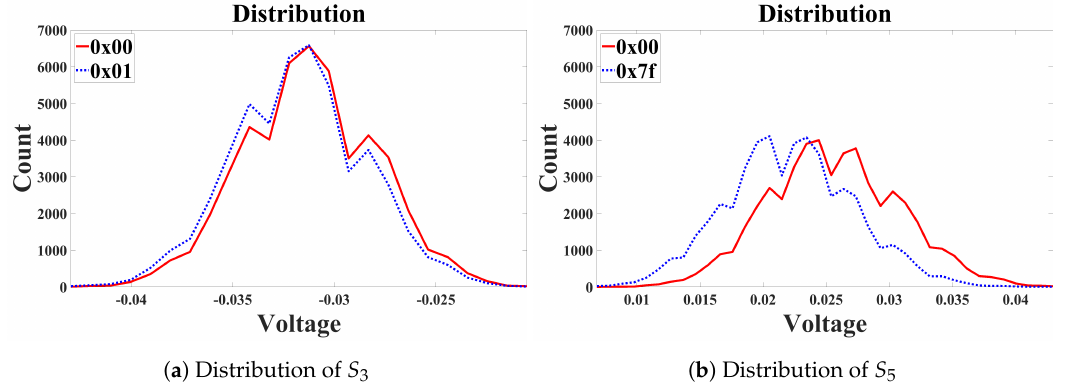
Figure 5. Distributions of power consumption that occurs when executing copy operation and xtime operation of